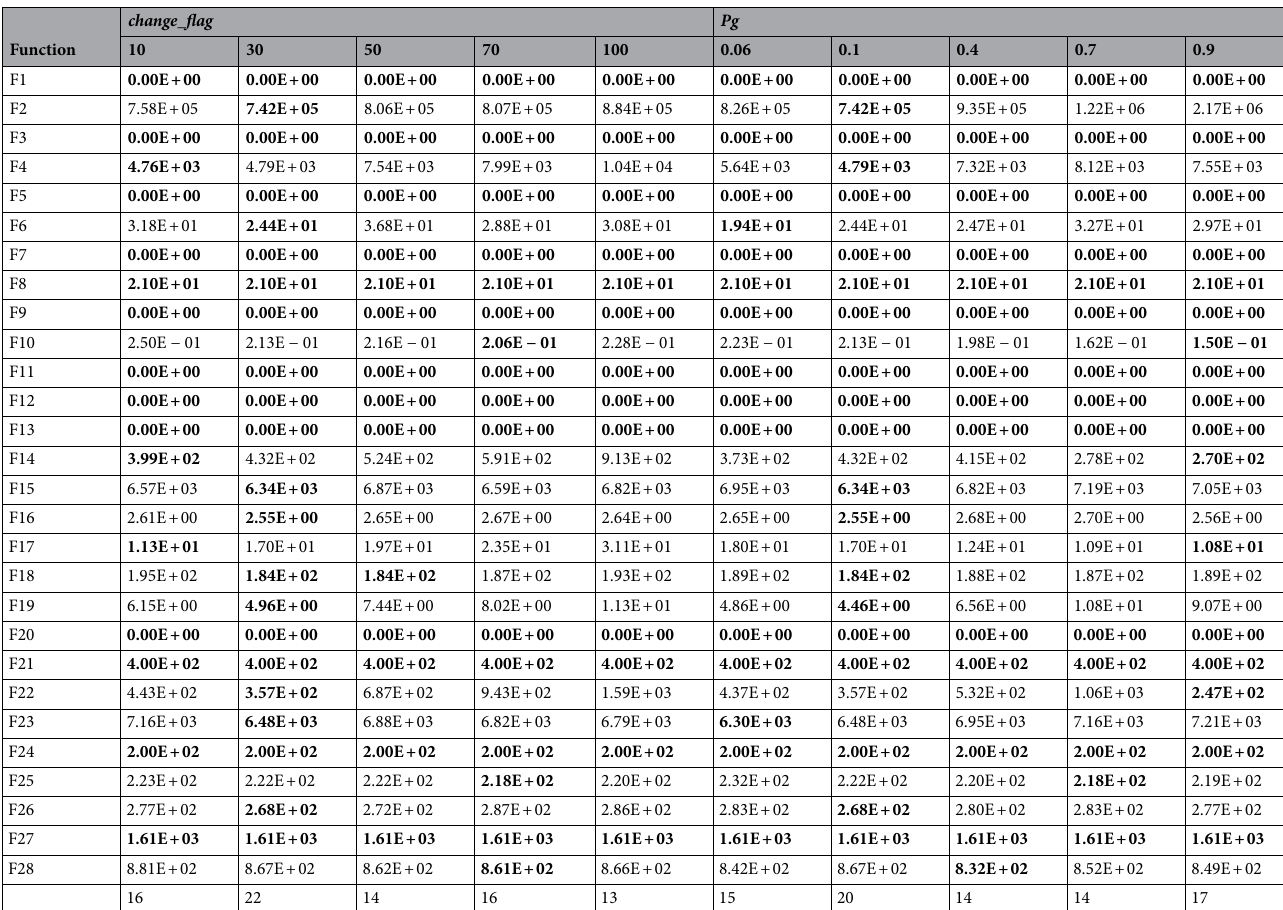
Table 1. Effect of parameters change_flag and Pg on IGTOA. Note: The parameters that perform best on each function are